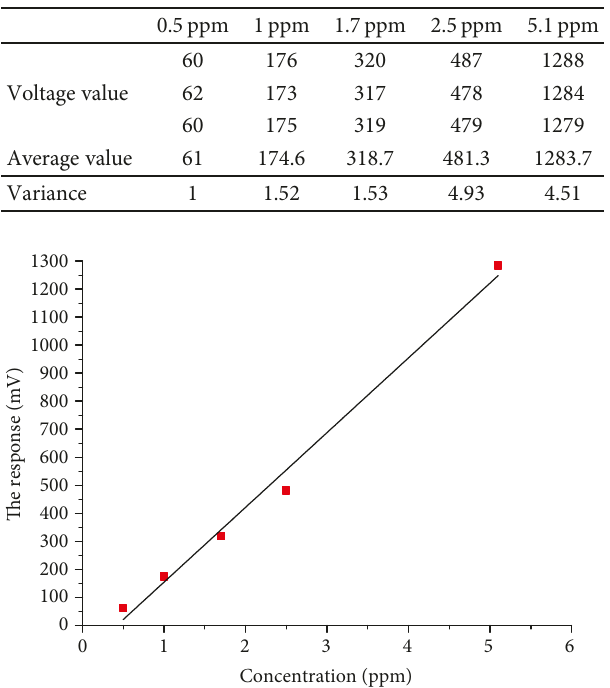
Table 2: Experimental results of concentration-response.